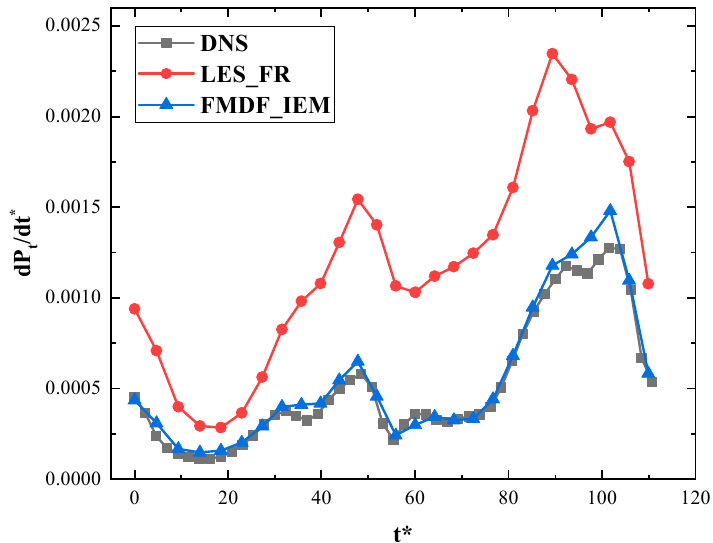
Figure 4. Derivative of total product mass fraction versus dimensionless time of DNS, LES, and FMDF when M c = 0.8.